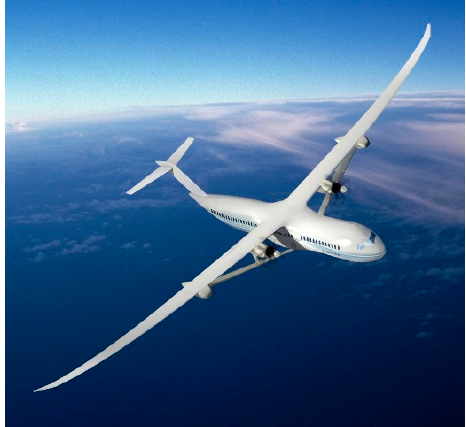
Figure 29. SUGAR Volt truss-braced wing aircraft concept.